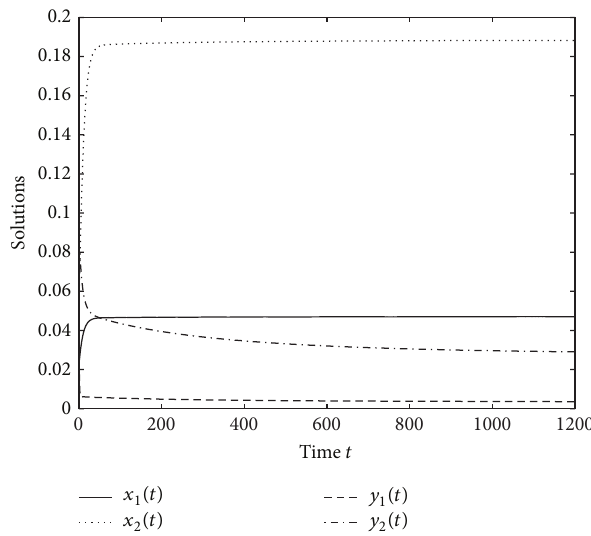
Figure 2: The temporal solution found by numerical integration of system (2) with 𝜏 = 3